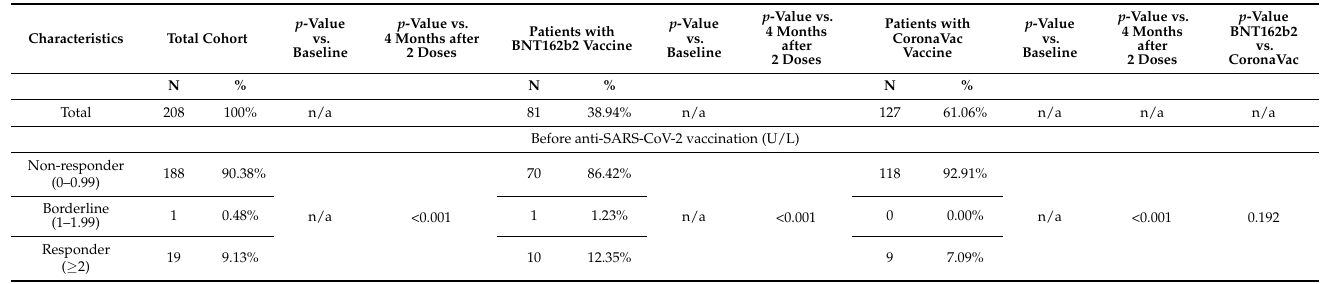
Table 2. Humoral immune response of patients before and after anti-SARS-CoV-2 vaccination. Plasma levels of IgG anti-SARS-CoV-2 were measured before vaccination, 2 months and 4 months after a two-dose vaccination, and 4 months after a booster dose. The results of the total cohort stratified by the vaccine used for the two-dose vaccination (BNT162b2 or CoronaVac) are detailed. Data are expressed as numbers (N) and percentages (%). p -values of comparisons are